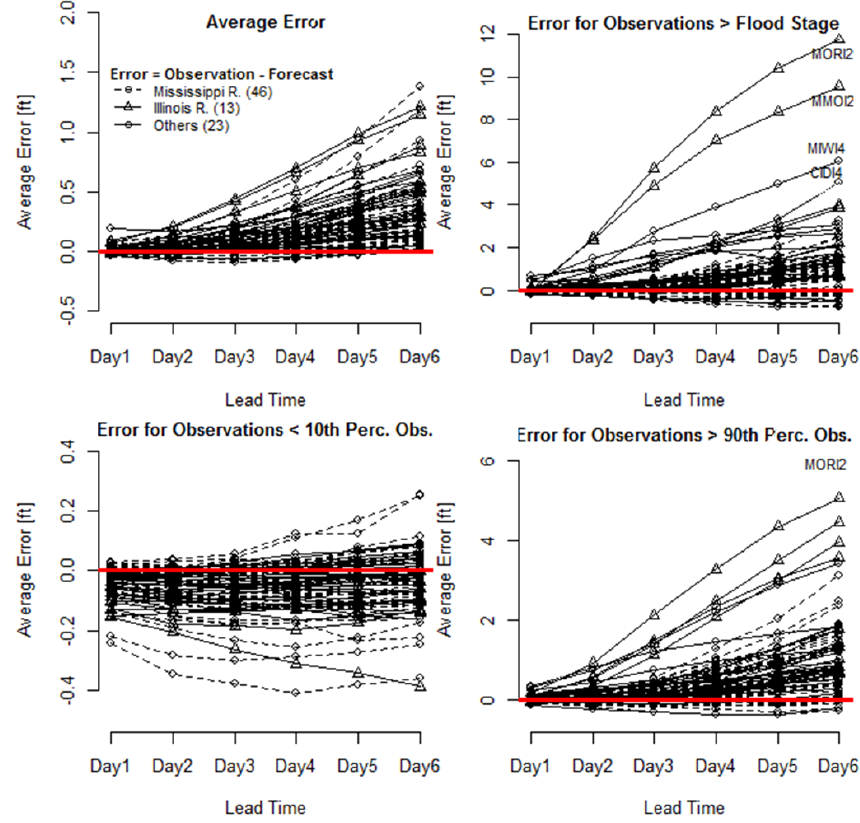
Figure 4. Forecast error for 82 river gauges that the NCRFC publishes daily forecasts for. In counterclockwise direction starting at the top left: (a) average error; (b) error on days that the water level did not exceed the 10th percentile of observations; (c) error on days that the water level exceeded the 90th percentile of observations; (d) error on days that the water level exceeded minor flood